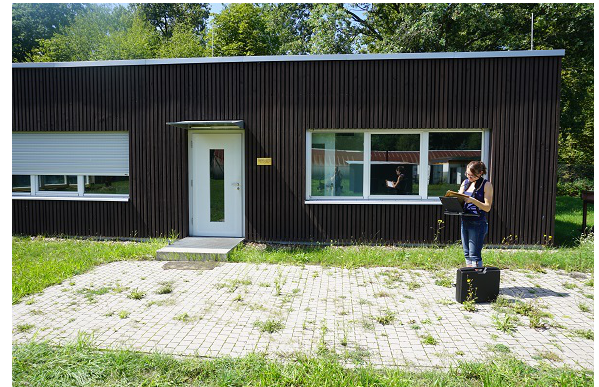
Figure 1. One building used for data collection